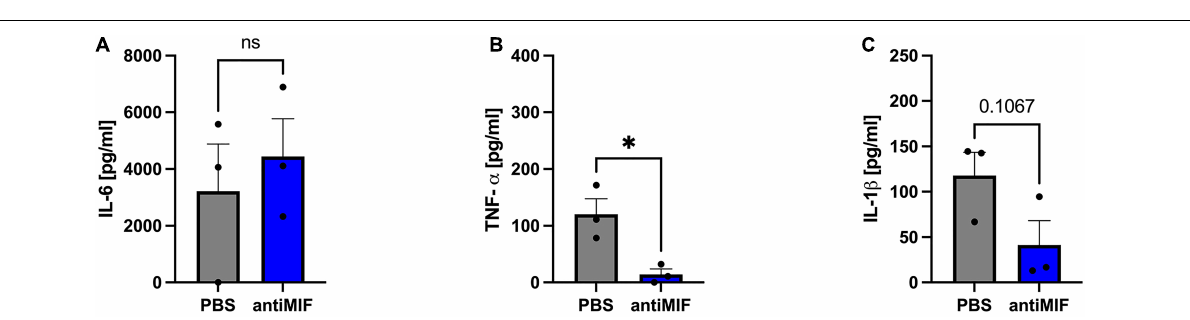
FIGURE 10 | Release of IL-6, TNF- α , and IL-1 β from ASCs from chronic non-healing wounds (Group B) following hypoxia and neutralization of exogenous MIF via an anti-MIF antibody. Cells were treated with anti-MIF antibody (NIH/IIID.9) and cultured in growth medium at hypoxic oxygen levels of < 1% O 2 . Supernatants of ASCs were collected at 24 h after induction of hypoxia and ELISA were performed to assess cytokine secretion by ASCs under normoxic and hypoxic conditions. Results are displayed for (A) IL-6 ( n = 3), (B) TNF- α ( n = 3), and (C) IL-1 β ( n = 3). Data are mean values ± SEM (unpaired, two-sided t -test, not significant). ∗ p <